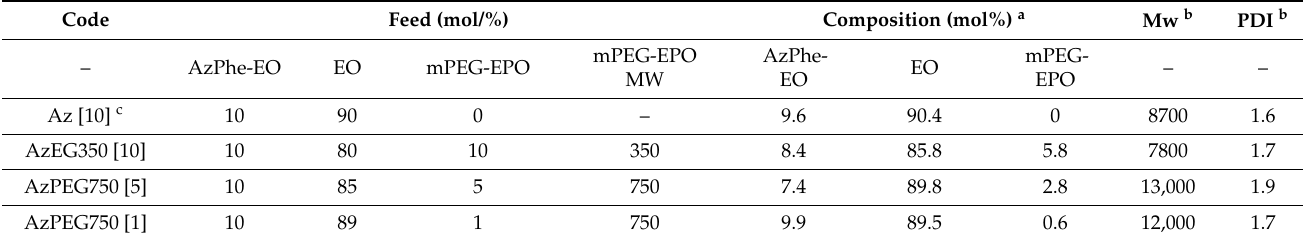
Table 1. Characterization of the prepared